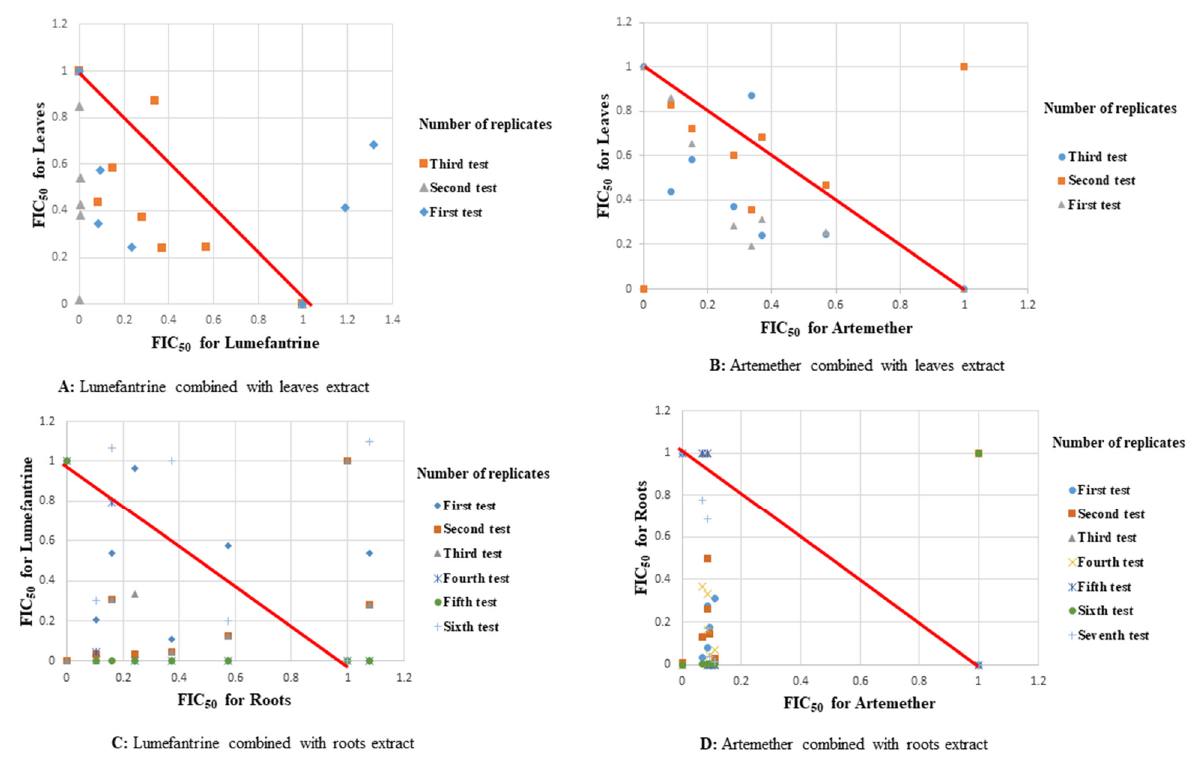
Figure 1. Scatter plots of drugs-extracts combinations against W2 strain of P. falciparum .